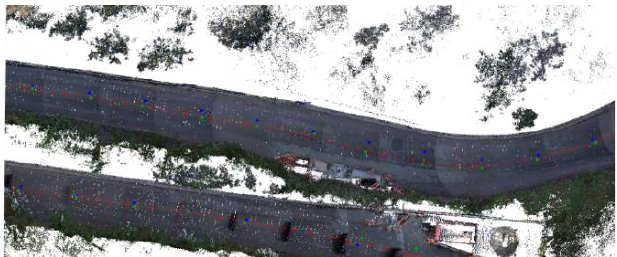
Figure 14. Comparison between the polylines of the ground truth, the alignment and the trajectory in a no painted road. Ground truth in red, alignment in green and trajectory in